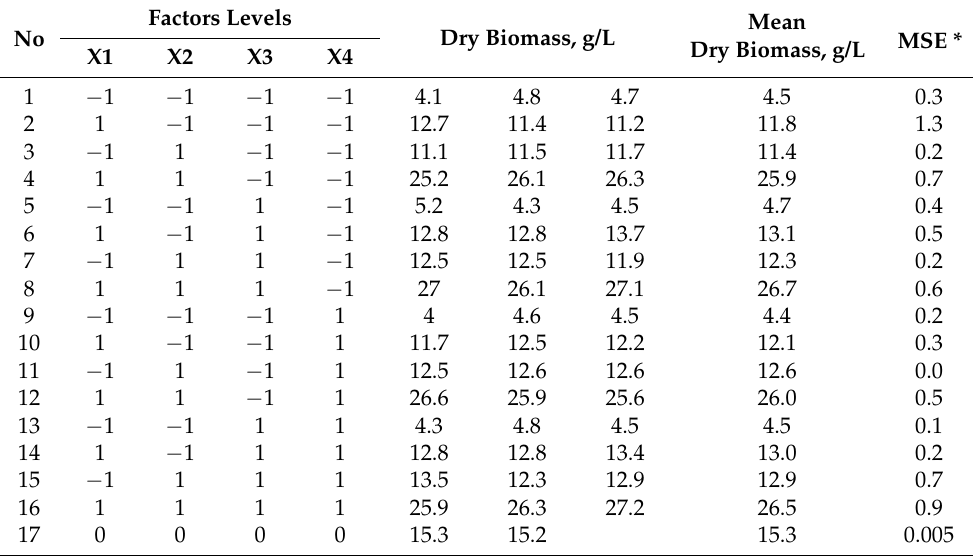
Table 3. The planning matrix and the results of the full factorial experiment 2 4 .